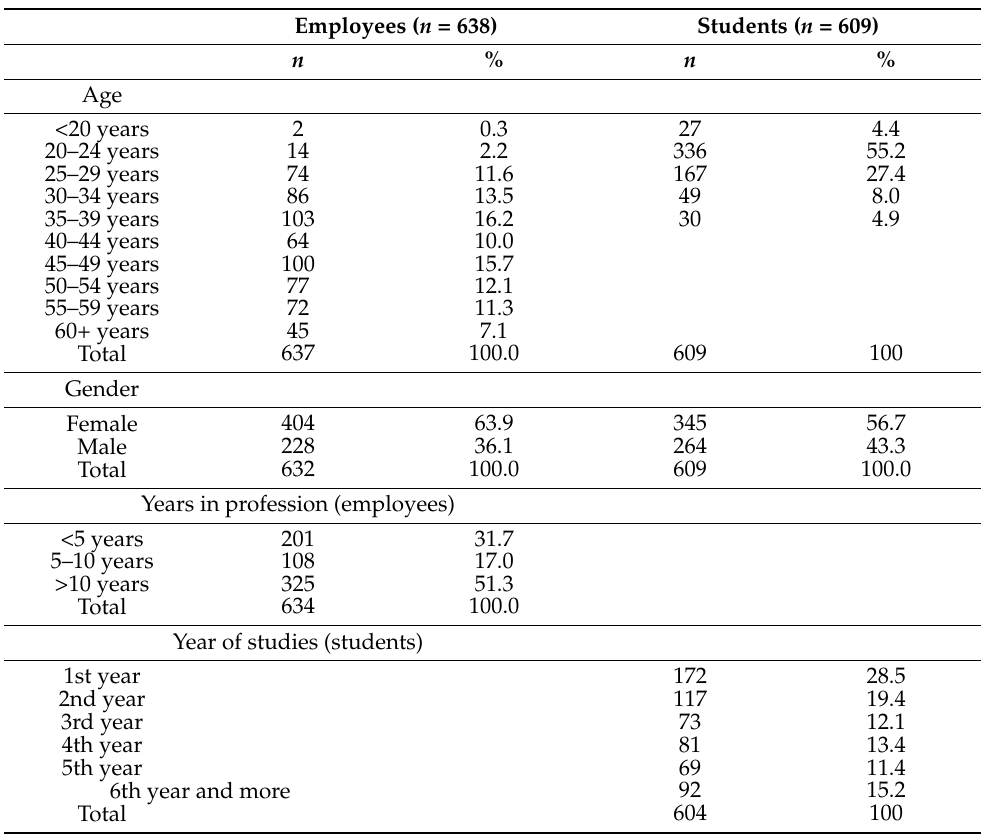
Table 1. Socio-demographic characteristics of study participants ( n = 1247), stratified by professional group (employees vs.